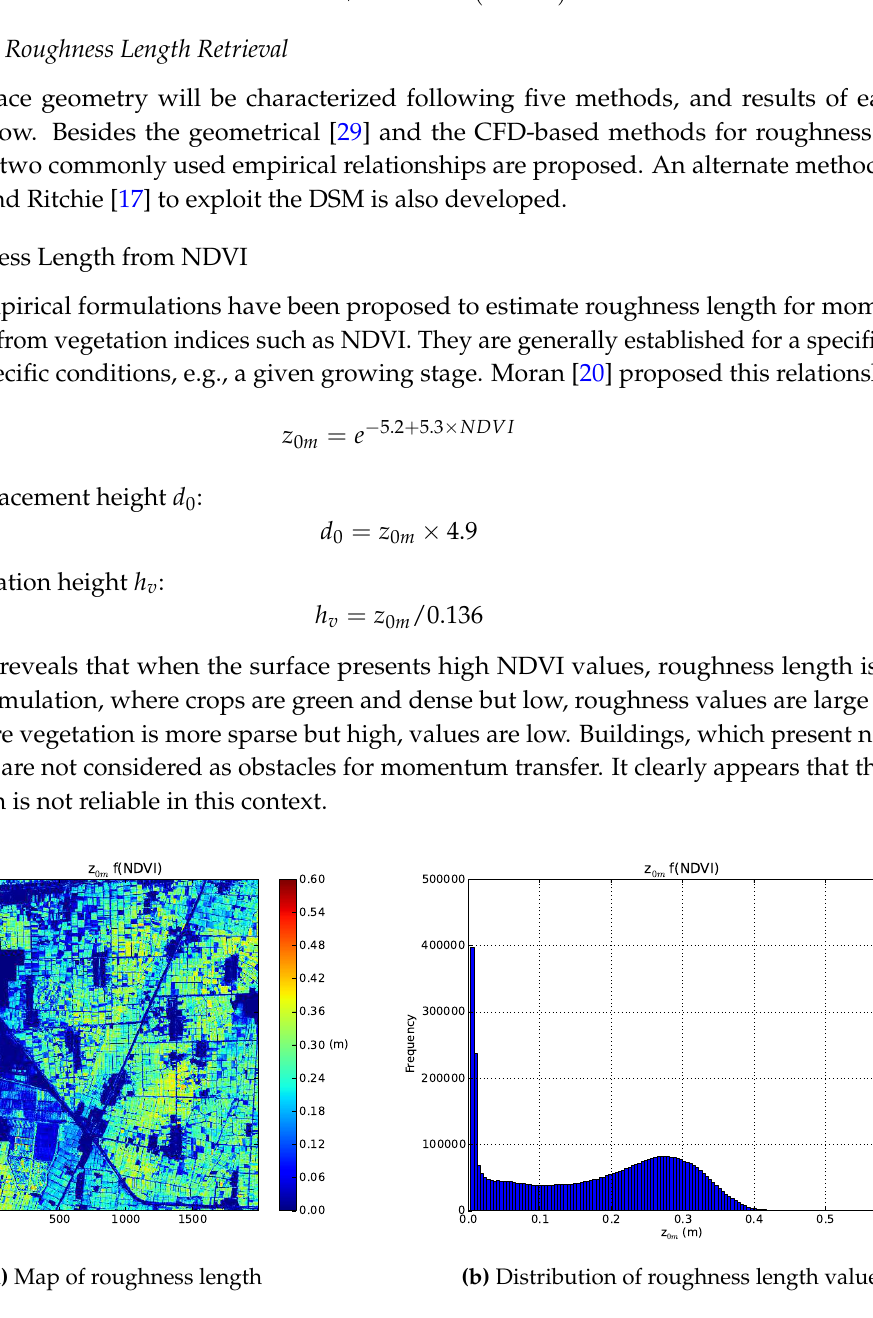
Figure 3. ( a ) Map and ( b ) frequency distribution of roughness length for momentum transfer values over the Yingke oasis station following Moran’s